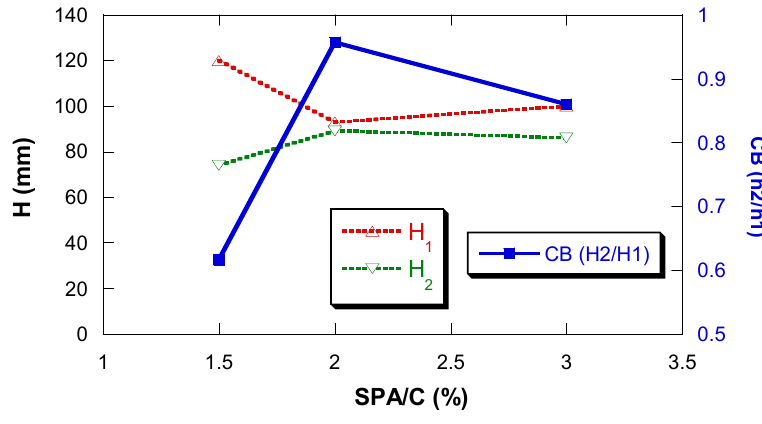
Figure 11. L-box tests results.